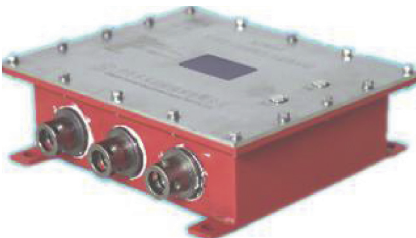
Figure 3: Roof pressure monitoring